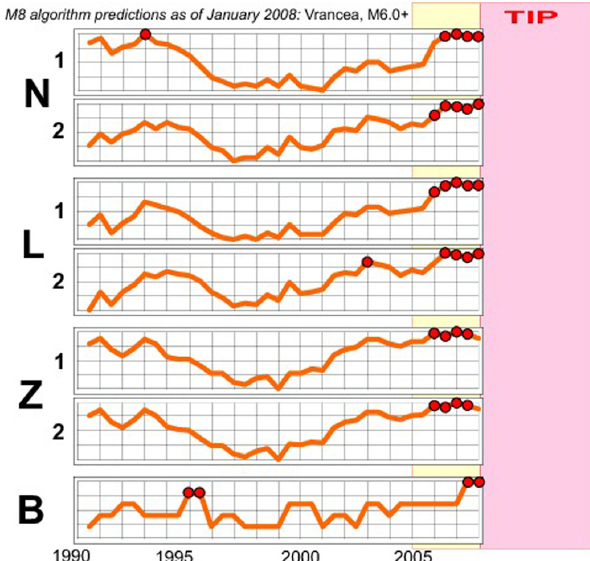
Fig. 15. Application of the standard version of the M8 algo- rithm (Kossobokov, 1997) to the RomPlus catalogue for magnitude M = 6 . 0 + . Plotted are normalized graphs of seven measures of seismic activity depicting the dynamical state of the Vrancea re- gion in terms of seismic rate N (two measures, N 1 and N 2 ), rate differential L (likewise two measures, L 1 and L 2 ), dimensionless concentration Z (also Z 1 and Z 2 ), and a characteristic measure of earthquake clustering B . The extreme values of these quantities in the extended phase space of the system are outlined by red circles. The M8 algorithm raises an alarm – called Time of Increased Prob- ability (TIP) – in a given geographic region, when the state vector (N 1 ,N 2 ,L 1 ,L 2 ,Z 1 ,Z 2 ,B) enters a pre-defined subset of this phase space: previous pattern recognition has determined that, in this sub- set, the probability of an above-threshold event increases to a level that justifies the alarm; see Sect. 7.2.1 and Appendix C here, as well as Kossobokov (2006) and Zaliapin et al.